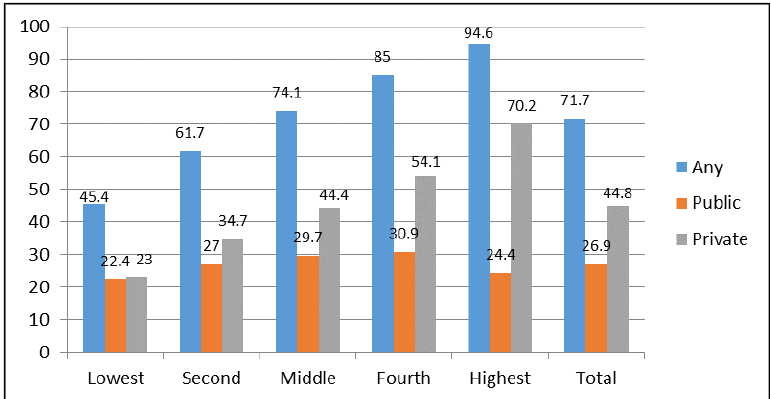
Figure 1. Delivery in a health facility by wealth quintiles in 2008. Source: Egypt Demographic and Health Survey [22].